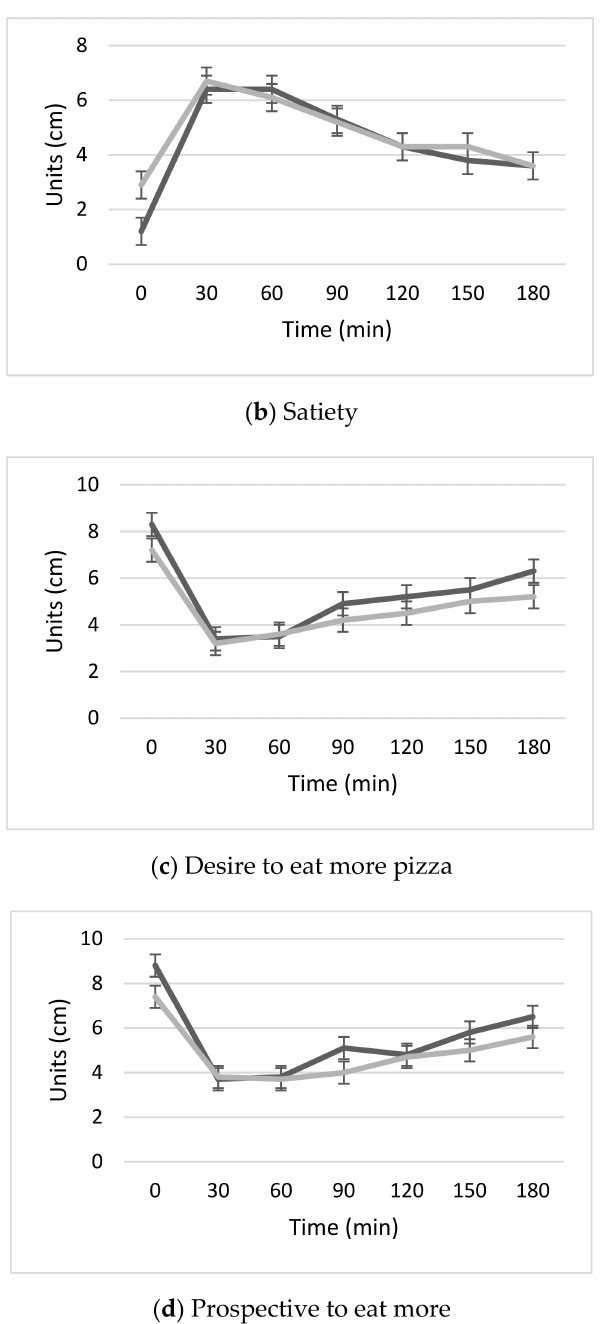
Figure 3. ( a ). Hunger, ( b ). Satiety, ( c ). Desire to eat more pizza and ( d ). Prospective food consumption expressed as mean ± standard error of the mean (SEM) perceived by the participants from the beginning of the test for 3 h, every 30 min, using a 10 cm Visual Analogue Scale (VAS). Dark grey: standard pizza. Light grey: seawater